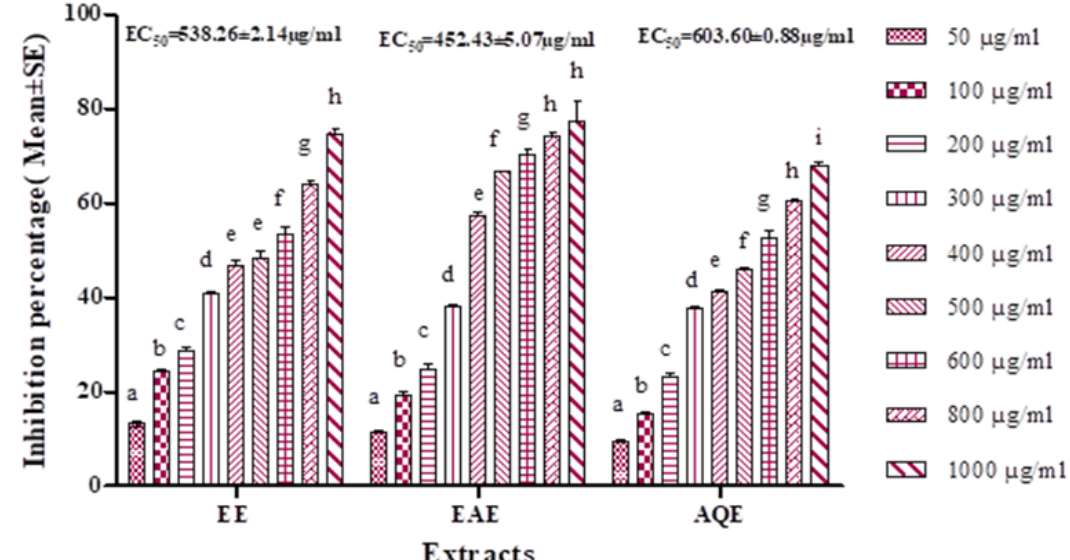
FIGURE 4 - Lipid peroxidation inhibition potential (LPIP) of seed extracts. Different letters indicate the significant differences from each other at P